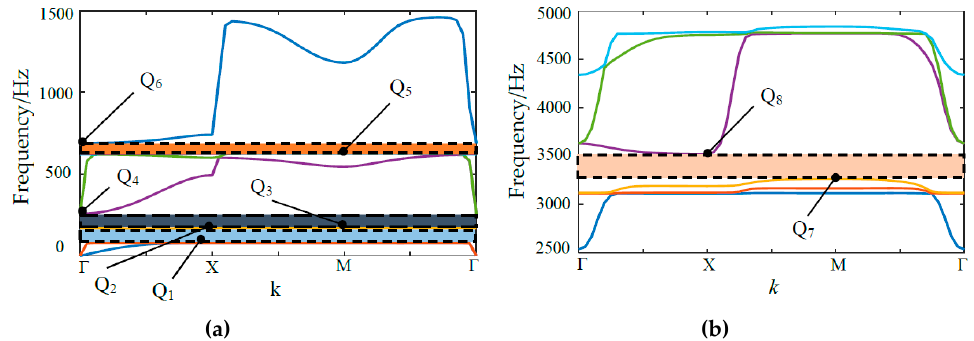
Figure 2. ( a ) The diagram of the first three band gaps (BGs); ( b ) The diagram of the fourth BG.